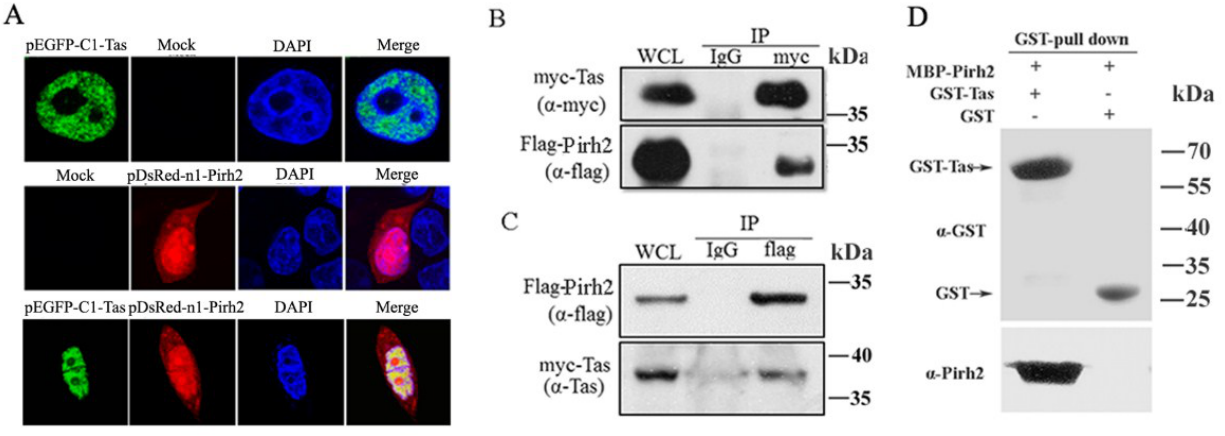
Figure 1. Tas interacts with Pirh2. ( A ) Tas colocalized with Pirh2 in nucleus. pEGFP-C1-Tas or/and pDsRed-N1-Pirh2 were transfected into 293T cells, 24 h after transfection, nuclei were visualized with DAPI staining; ( B ) Co-IP of Tas and Pirh2. 293T cells were cotransfected with myc-Tas and Flag-Pirh2, 24 h post transfection, the whole cell lysate was harvested and Tas was immunoprecipitated with anti-myc and normal IgG was used as negative control, then the immunoprecipitates were detected by Western blot using anti-myc and anti-Flag; ( C ) Reciprocal Co-IP of Tas and Pirh2. Immunoprecipitation (IP) was performed with anti-Flag, and analyzed by Western blot using anti- Flag and anti-Tas; ( D ) In vitro interaction between Tas and Pirh2. The purified Pirh2 protein was incubated with GST or GST-Tas agarose beads. GST pull down was then performed, and precipitates were detected by Western blot using an anti-Pirh2 antibody. Purified GST and GST-Tas used in the pull-down assay detected